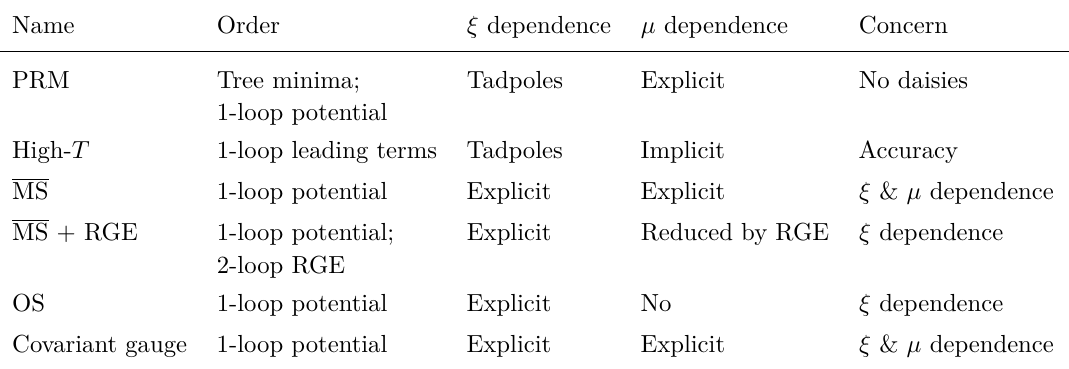
Table 1 . Comparison of perturbative treatments of the effective potential explored in this work. In the final column, we show our initial concerns about the treatment that we investigate in detail in section